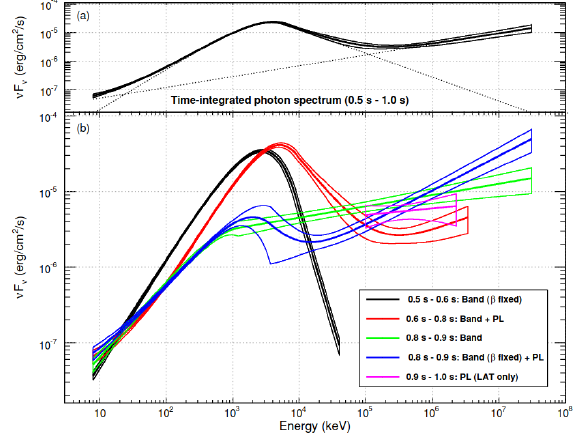
Figure 3. Time − integrated spectrum (upper panel) and model spectra (with ± 1 σ error contours) used to fit the emission of GRB 090510 in different time bins. Reprinted with permission from Ref.